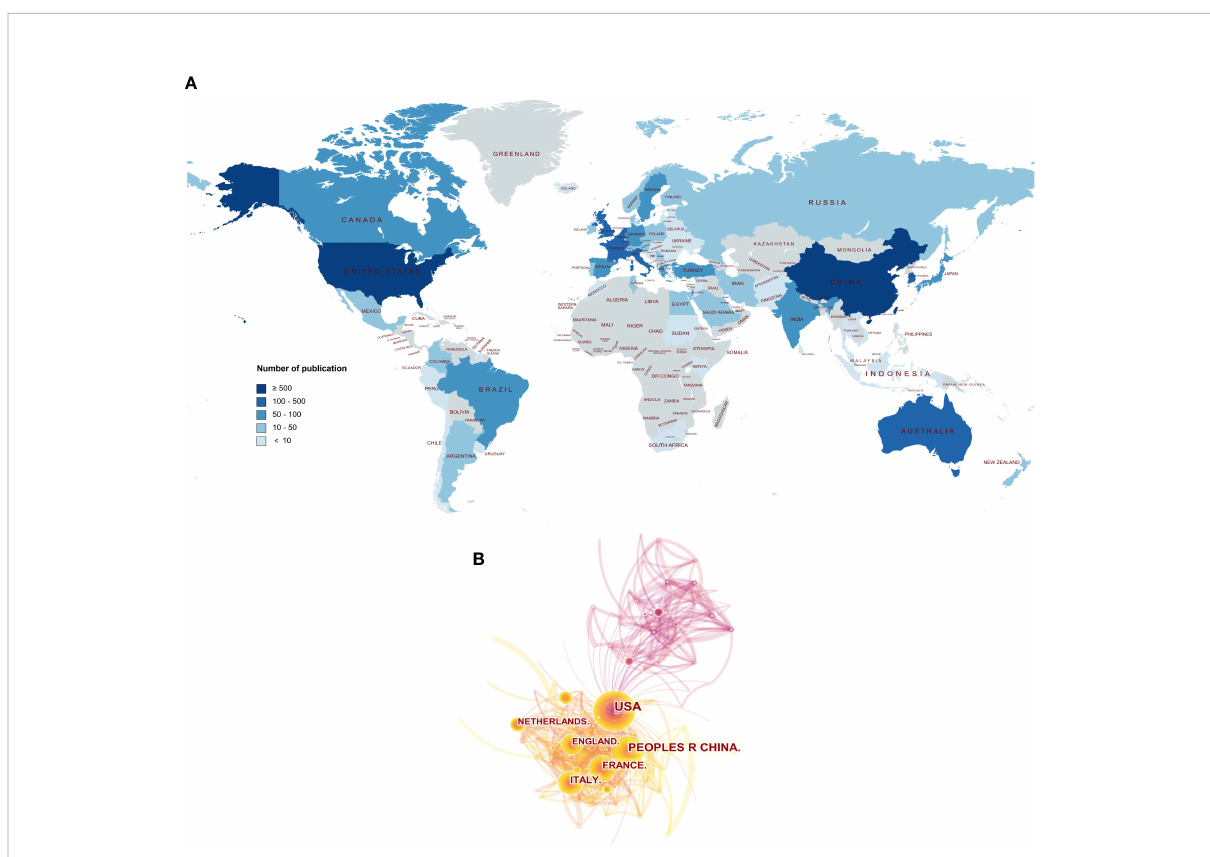
FIGURE 2 The publishing performance of countries. (A) The worldwide view of the research output of countries. The color intensity represents the number of publications. The world map was generated online (https://www.mapchart.net/index.html). (B) The collaboration between the countries. Each node represents a country, and the number of publications was re fl ected by the node